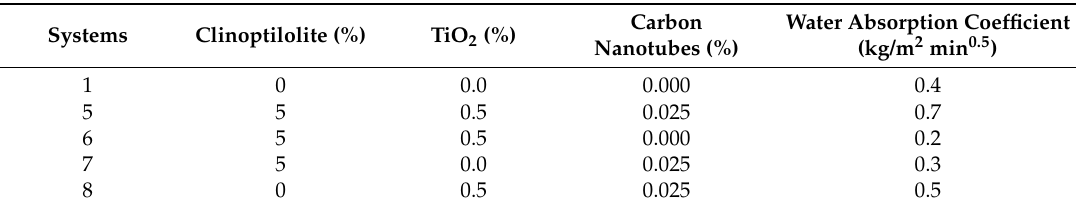
Table 8. Water absorption